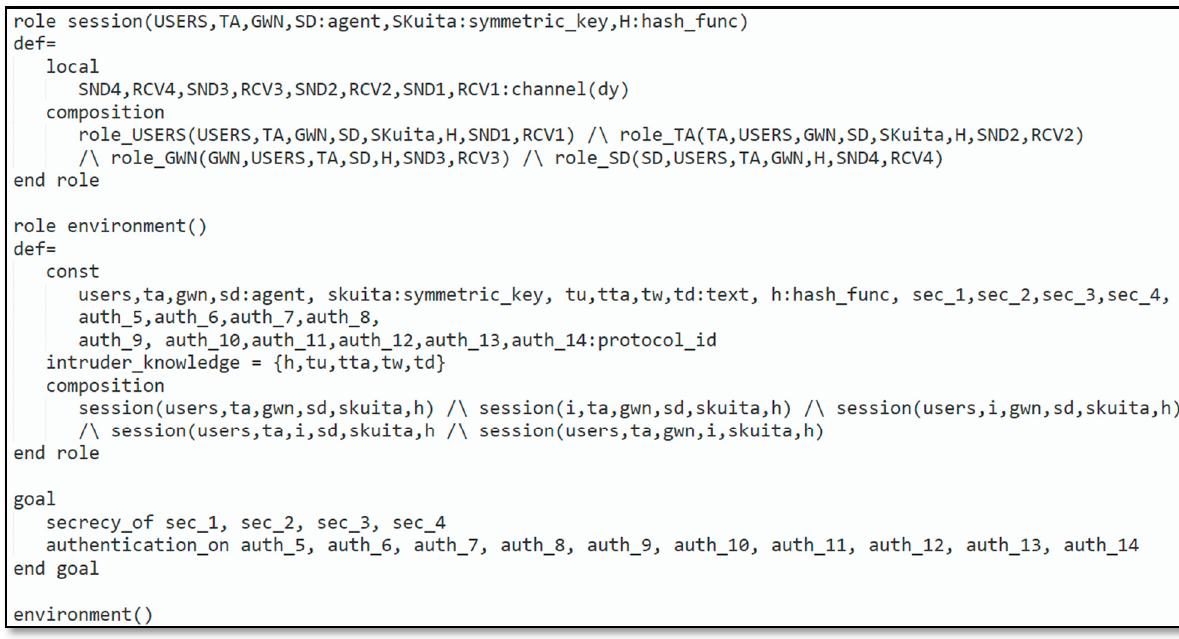
Figure 7. Role session, environment, and goal.